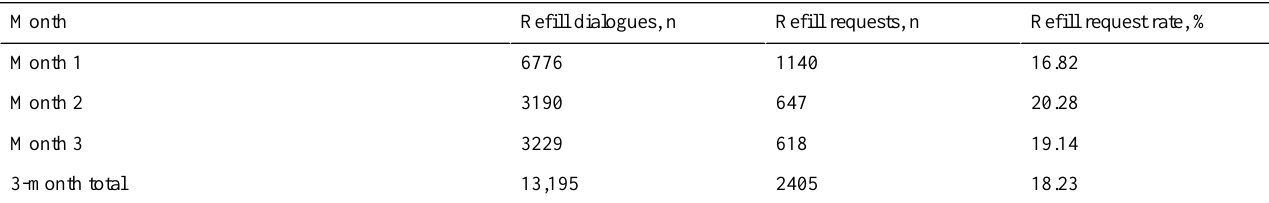
Table 2. Refill request rate for text message group by month.